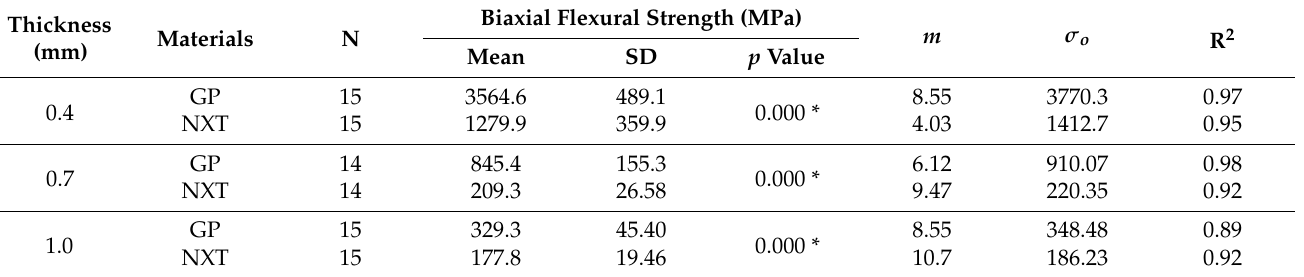
Table 4. Weibull analysis of biaxial flexural strength.